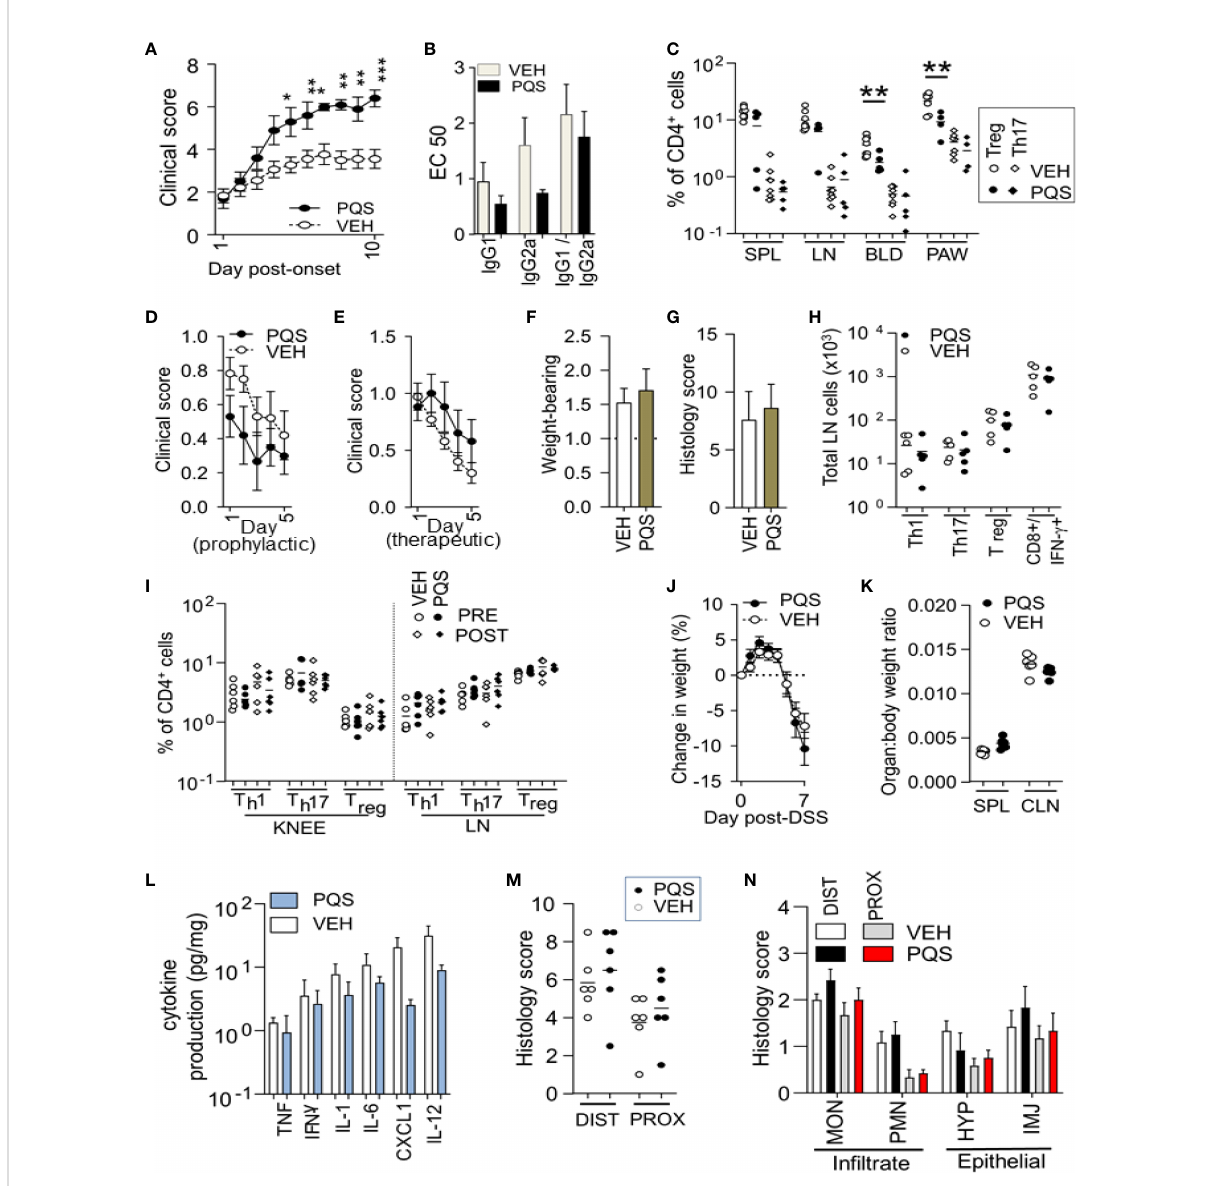
FIGURE 1 The effect of PQS differs between in vivo models of disease. PQS modulation of disease activity in CIA (A – C) , AIA (D – I) and DSS (J – N) . (A) : Clinical severity from the onset of paw swelling (day 1) to the termination of the experiment (day 10); (B) Anti-collagen humoral responses for IgG1 and IgG2a antibodies and their ratio IgG2a:IgG1; titres were measured by a dilution assay and the results expressed as EC50; *p<0.05, **p<0.01, ***p<0.001 (n = 8 vehicle, n = 5 PQS); (C) Analysis of Th17 + or CD4 + FoxP3 + Treg cells in affected paws (PAW), lymph nodes (LN) spleens (SPL) and blood (BLD); **P<0.01 (vehicle n = 8; PQS n = 5); (D) score (change in knee width) after immunisation and (E) after intra- articular injection; n = 5; (F) Weight-bearing and (G) histological scores of joint damage in AIA mice; (H) Th1, Th17 or Treg cells in the inguinal lymph nodes of vehicle or PQS-treated animals; n = 6; (I) CD4+ Th1, Th17 and FoxP3+ T cells in the arthritic knee or lymph nodes of mice with AIA; n = 6; (J) Dextran sulphate induced changes in body weight, n = 6; (K) Ratio of the weights of spleen or colon with total body weight; n = 6; (L) Log cytokine production by ex vivo colon cultures for TNF, IFN- g , IL-1 b , IL-6, CXCL1 and IL-12 (n = 6); (M) Overall histological assessment of the distal (DIST) and proximal (PROX) colon; (N) Analysis of in fi ltrating monocytes (MON) or granulocytes (PMN), and the hyperplasia (HYP) or injury (INJ) of intestinal epithelial cells (n =